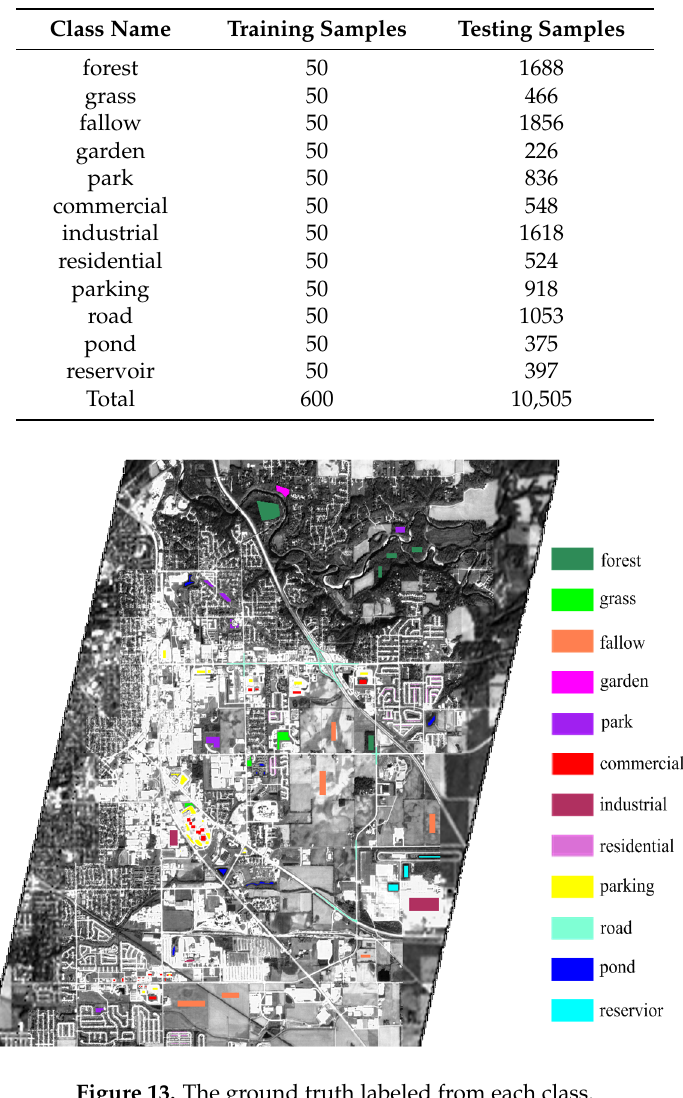
Table 6. The number of ground truth labeled in the study area.